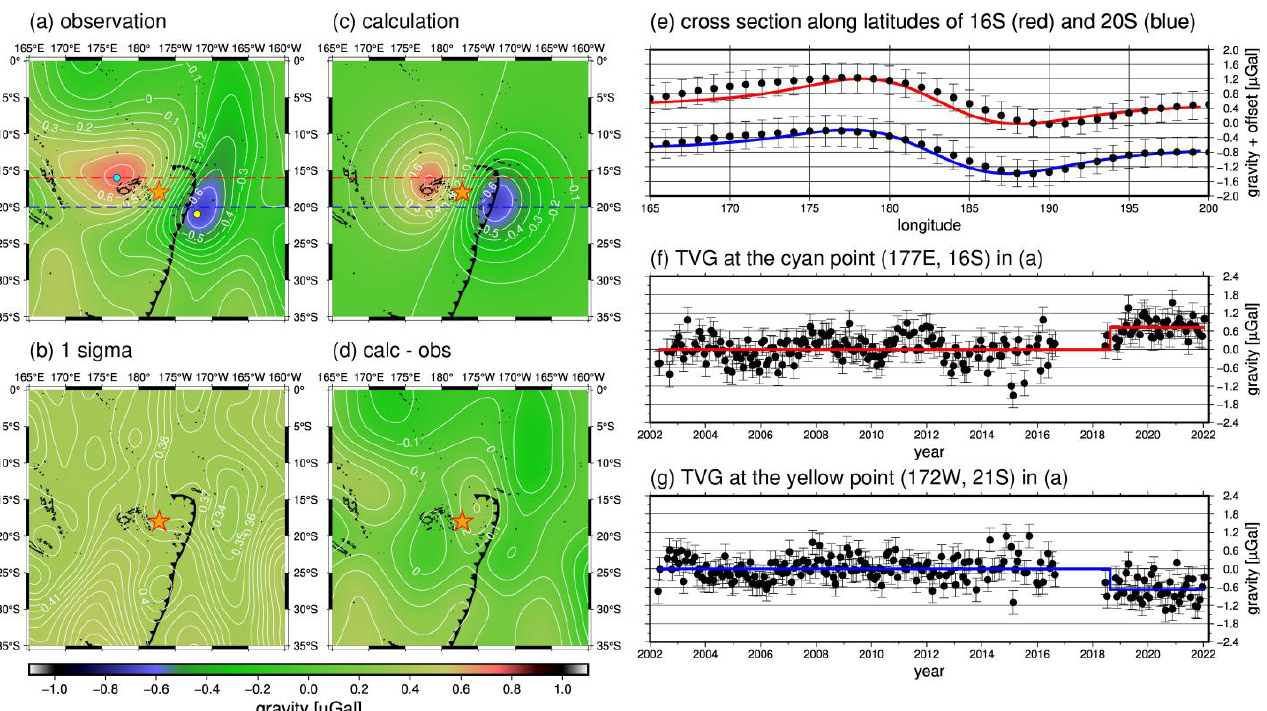
Figure 2. The coseismic gravity change of the Fiji deep-focus earthquake. ( a ) The distribution of coseismic gravity change obtained by time series analysis of GRACE and GFO data. The broken red and blue lines show the latitudes of 16S and 20S, respectively. The contour interval is 0.1 μGal. The star represents the center of the fault as determined by the model calculation. ( b ) The standard de- viation estimated simultaneously to the coseismic gravity change (the contour interval is 0.01 μGal). ( c ) The result of the model ’s calculation. ( d ) The difference between the observation and calculation results. ( e ) The cross section along the 16S and 20S latitudes in ( a , c ). The black dots represent the observation data shown in ( a ) with error bars of 1 sigma shown in ( b ). The red and blue solid curves represent the calculation results shown in ( c ). ( f ) Time-variable gravity at the location of the cyan